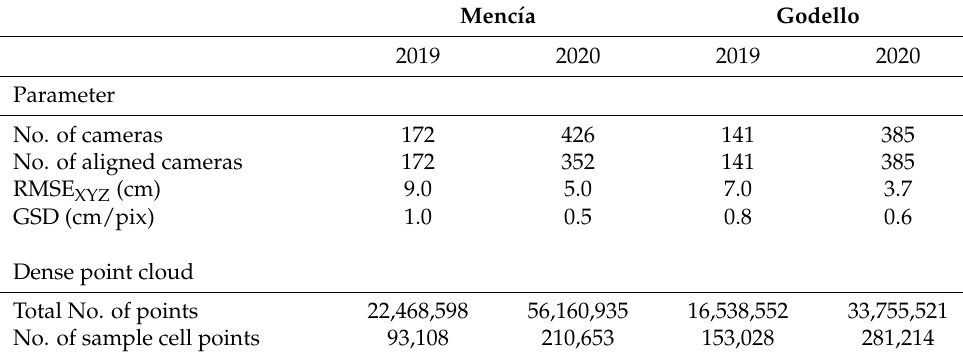
Table 3. Digital processing data calculated with structure from motion procedures for UAV images captured in the Menc í a and Godello vineyards in 2019 and 2020.